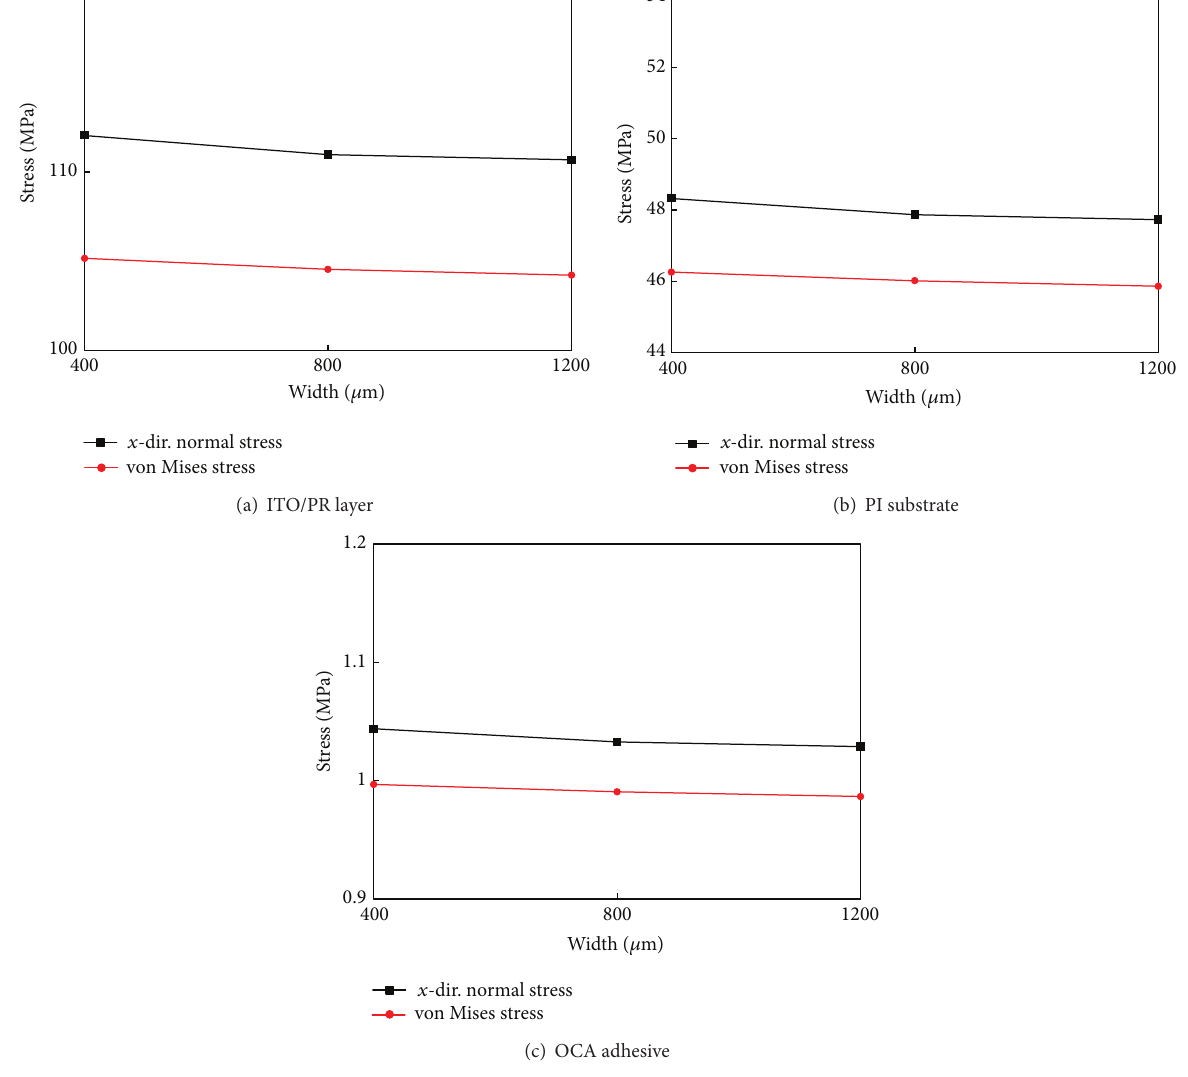
Figure 14: Effects of the SPS width on the bending stress.